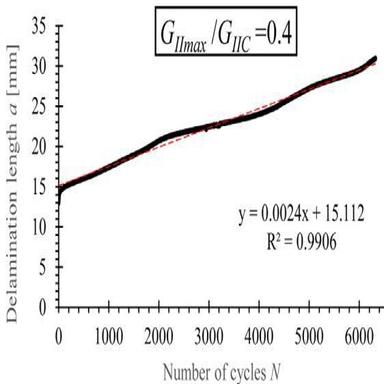
Example of average delamination growth as predicted with the EXT method.